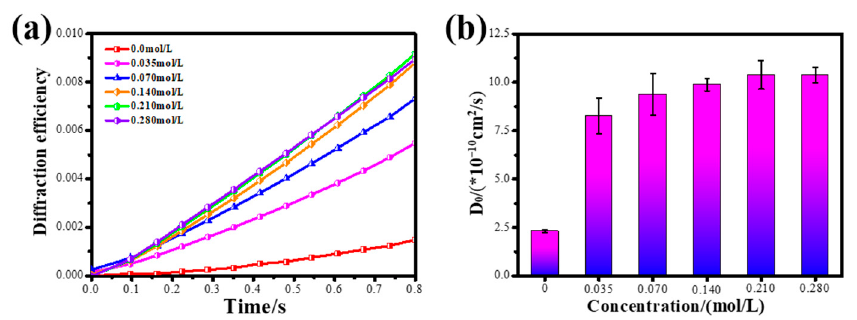
Figure 3. ( a ) The real-time diffraction efficiency of the photopolymer in the initial stage of exposure; ( b ) D ∗ of NVP in the photopolymer containing different concentrations of glycerol. 0